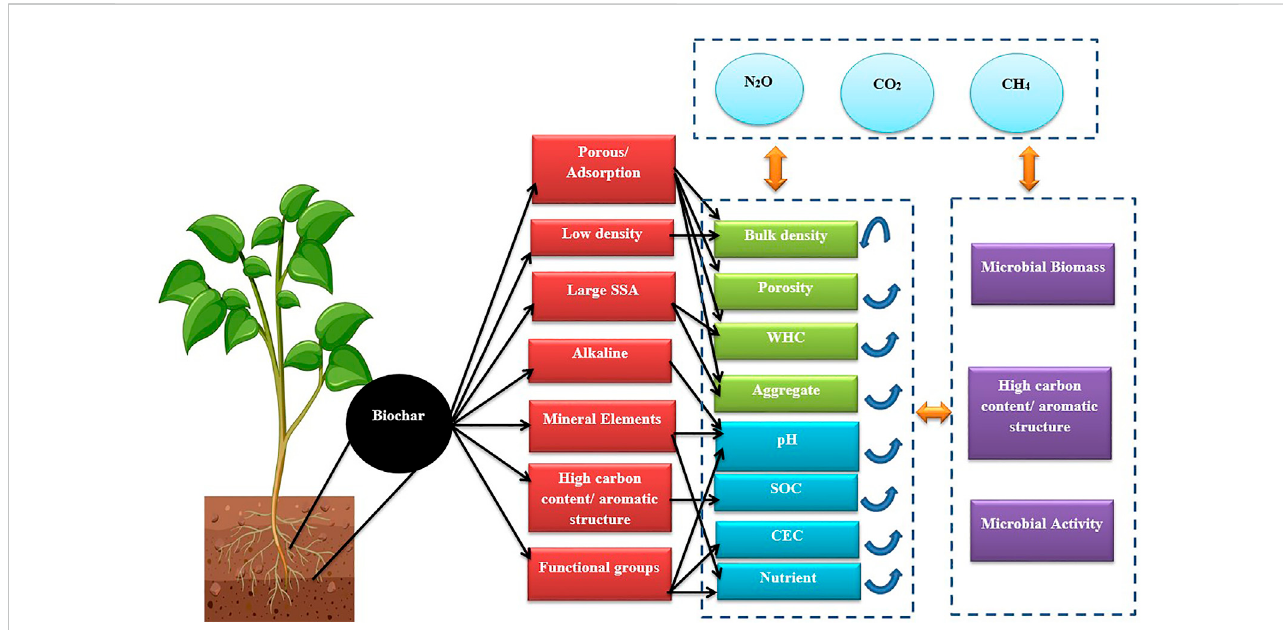
FIGURE 1 Effect of biochar application on soil physicochemical and biological properties; Carbon dioxide (CO 2 ), Cation exchange capacity (CEC), Nitrous oxide (N 2 O), Methane (CH 4 ), Soil organic carbon (SOC), Speci fi c surface area (SSA), Water holding capacity